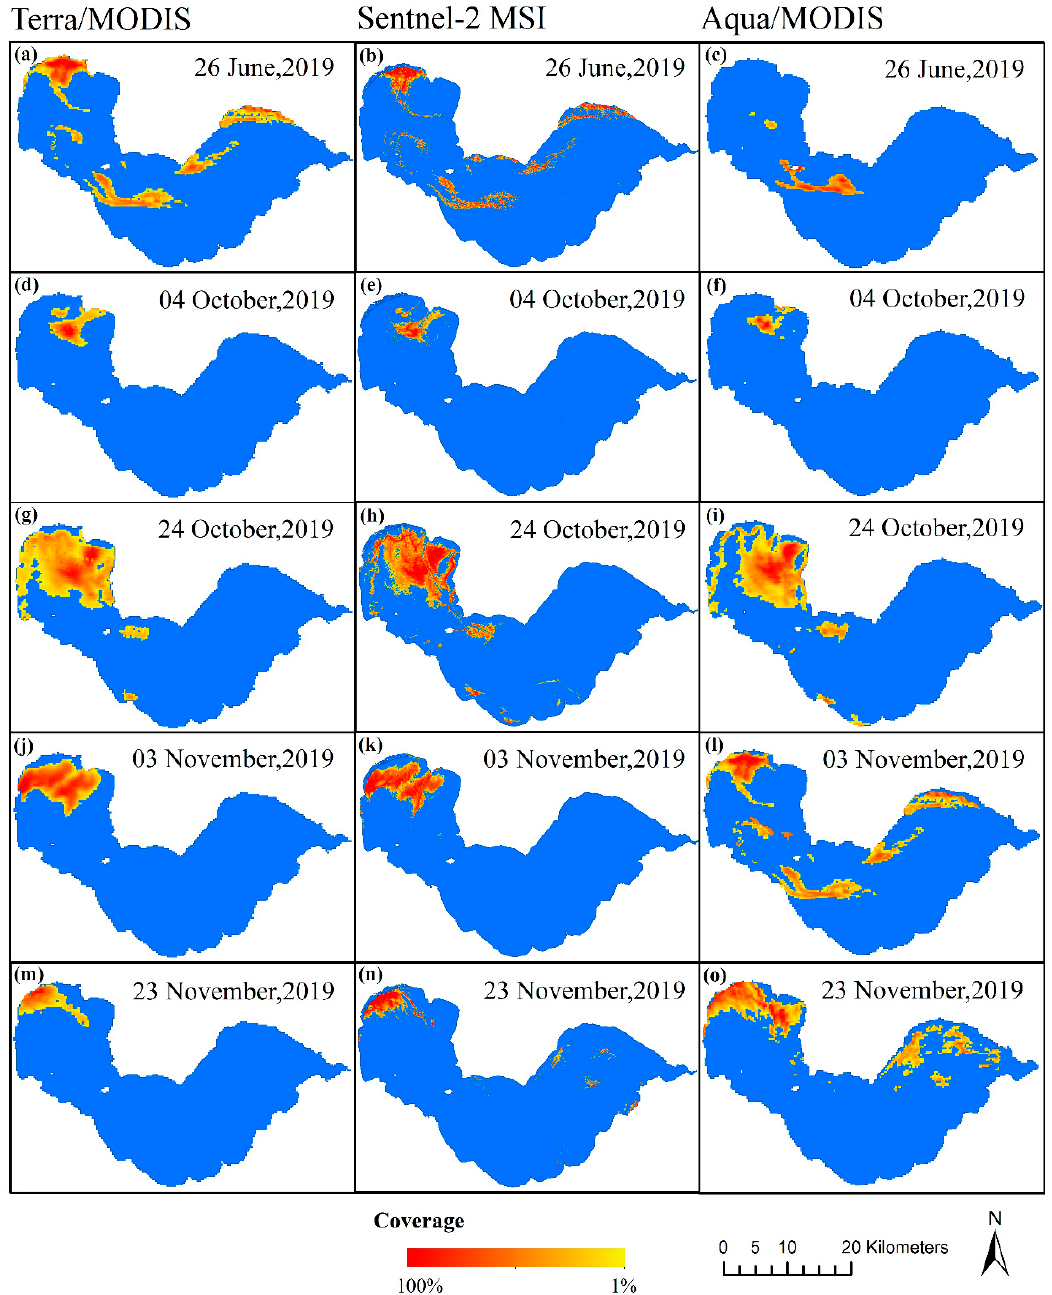
Figure 11. Variations of HAB from multi-satellite data: ( a , d , g , j , m ) results from Terra/MODIS, ( b , e , h , k,n ) results from Sen- tinel-2 MSI, ( c , f , i , l , o ) results from Aqua/MODIS. The HAB diurnal changes from Landsat 8 and MODIS images on 19 August 2019 have no significant differences in the area and distribution. The morphology of HAB mon- itored by Terra (Figure 12a) was different from that of Landsat8 (Figure 12b), which may be due to the low quality (cloud coverage) of Terra/MODIS images on 3 August 2019. HAB